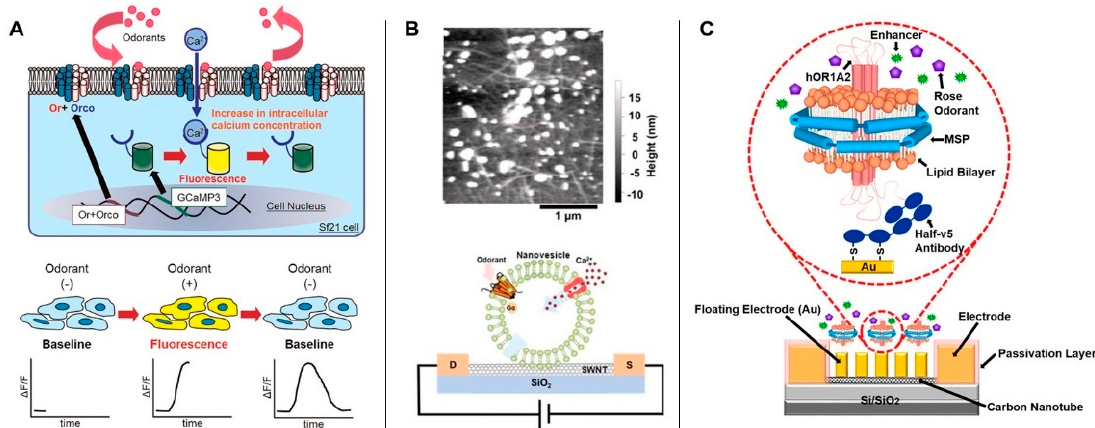
Figure 4. Olfactory receptor (OR)-based sensors. ( A ) Whole cell-based platform: odorant-stimulated ion transfer induces fluorescence illumination in the genetically modified cell [64]. (Reproduced with permission from Mitsuno et al. Sci. Rep.,